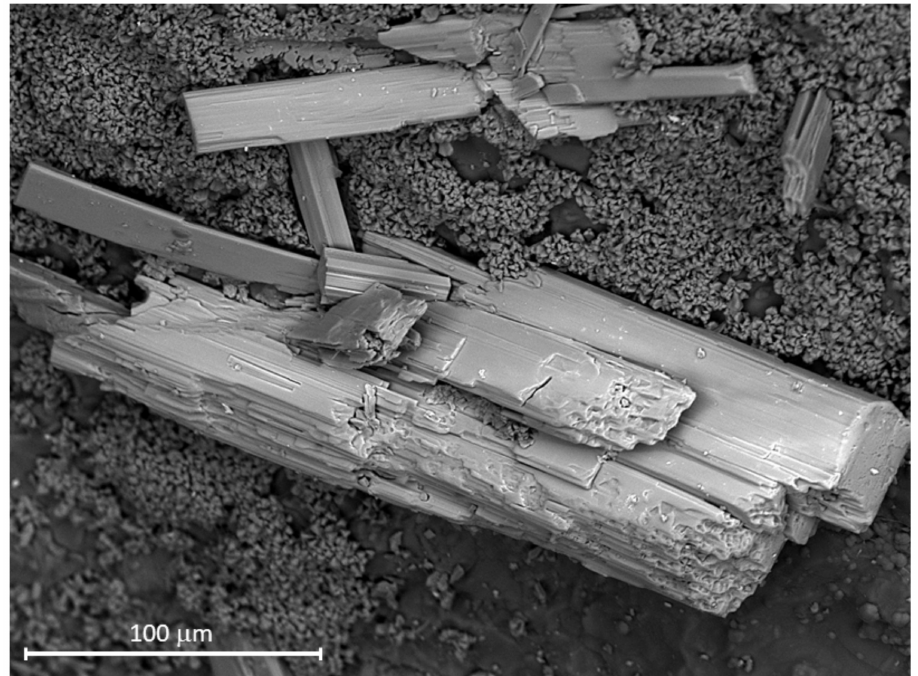
Figure 1. Scanning Electronic Microscope (SEM) image of rüdlingerite crystals from Fianel.